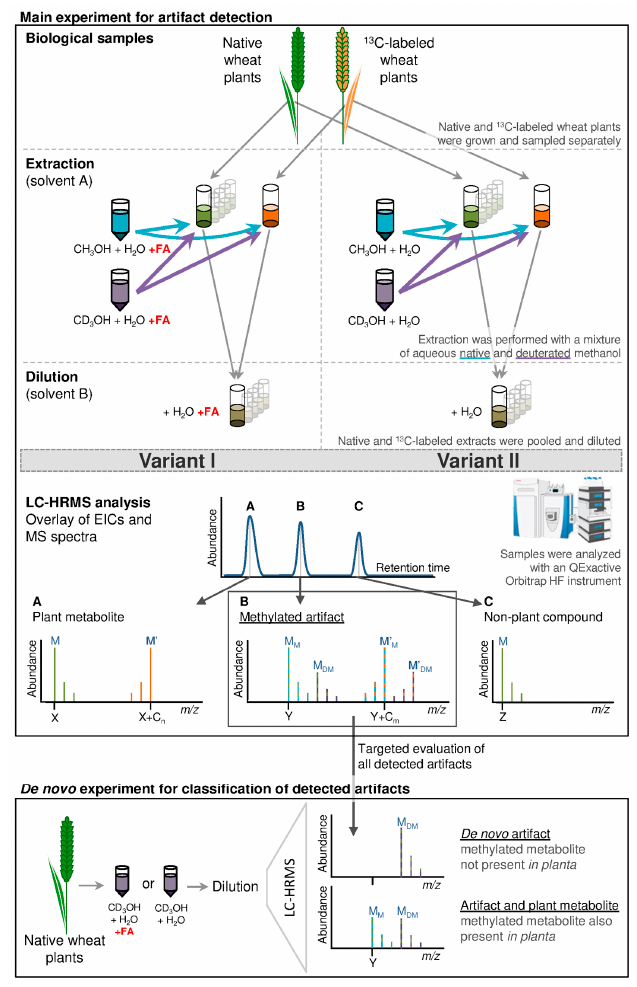
Figure 1. Overview of the experimental procedure and expected results for artifact compounds, plant metabolites and contaminants. Native and fully 13 C labeled wheat leaves were extracted with mixtures of native and deuterated aqueous methanol (3:1 ( v/v )) acidified with 0.1% formic acid (FA) for variant I and without the addition FA for variant II. The resulting extracts were combined and diluted with water (for variant I with FA) to obtain a final ratio of methanol/water of 1:1 ( v/v ). Samples were analyzed with LC-HRMS and an example chromatogram is shown. Schematically, the mass spectrum A represents a plant metabolite showing the characteristic isotope pattern originating from a native (M) and uniformly labeled plant leaf metabolite (M´). No additional deuterium containing isotopolog peaks are present. Mass spectrum B represents a methylated artifact where M M represents the artifact formed from the reaction of the native plant metabolite with native methanol. The mass of M M is increased by +14 or +32 compared to its educt (such as M in spectrum A ); M DM represents the deuterated methylated artifact (which originates from the reaction of M with CD 3 OH; mass increase of +17 or +35 compared to M); M’ M and M’ DM refer to the corresponding artifact analogs of the fully- 13 C-labeled plant metabolite M’. Mass spectrum C illustrates an unspecific signal not deriving from the plant, as no fully- 13 C-labeled peaks are present. Every single artifact served as a putative target in the de novo experiment which was used for classification of de novo artifacts. For this, native wheat leaf material was extracted with aqueous deuterated methanol (with and without the addition of FA) only. For artifacts classified as de novo M M (shown in mass spectrum B ) cannot be found after extraction and are therefore considered to be newly formed. If M M was present in the candidate spectra, the methylated metabolite had already been present in the analyzed sample prior to analysis and a proportion thereof was additionally formed during metabolite